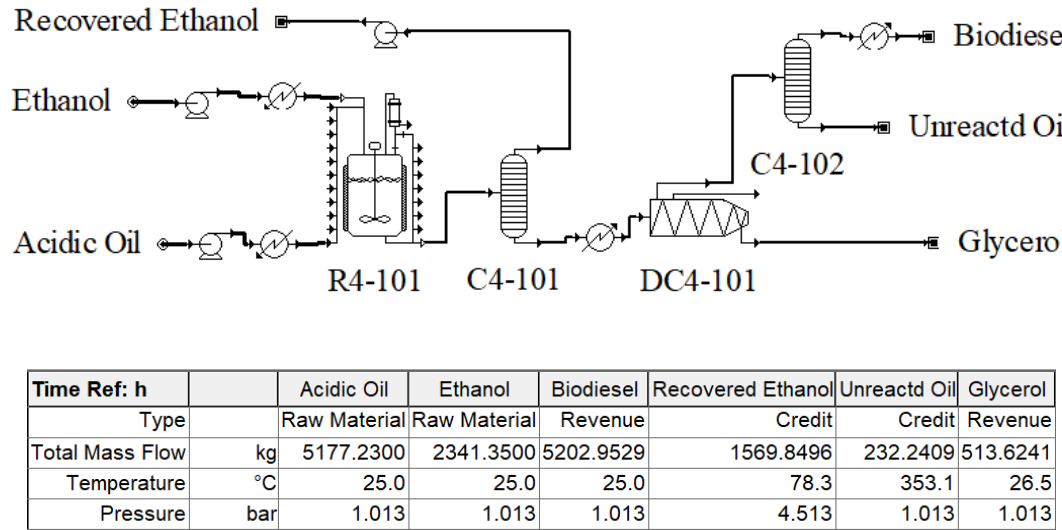
Figure 4. Technology option IV: R4-101 CSTR for the production of biodiesel, C4-101 first short cut distillation column to recover excess ethanol, DC4-101 centrifugal decanter to separate the glycerol, and C4-102 second distillation column to purify the biodiesel.